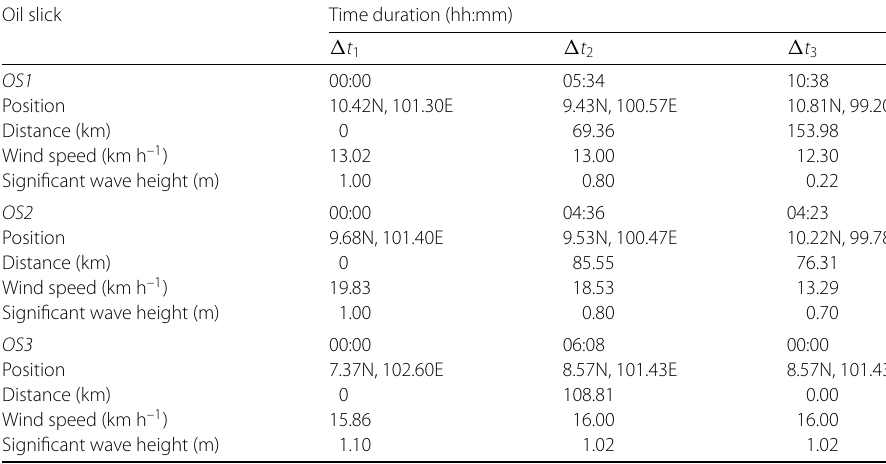
Table 1 The positions and the traveling distances of each of the three oil slicks and their corresponding wind speeds and significant wave heights at the three different times on 6 December 2018, a fine weather day